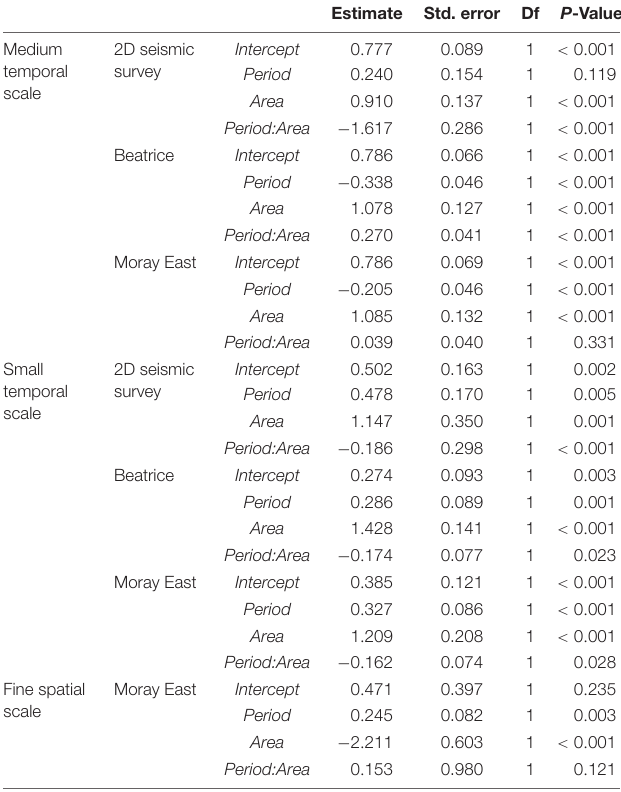
TABLE 3 | Results of the Poisson generalized linear mixed models used to investigate the effect of impulsive noise from offshore activities on the acoustic detection of dolphins at sites in the inner Moray Firth ( Reference Area ) and the southern Moray Firth ( Impact Area ) at the medium and small temporal scales and in the Impact Inner and Impact Outer arrays at the fine spatial scale.